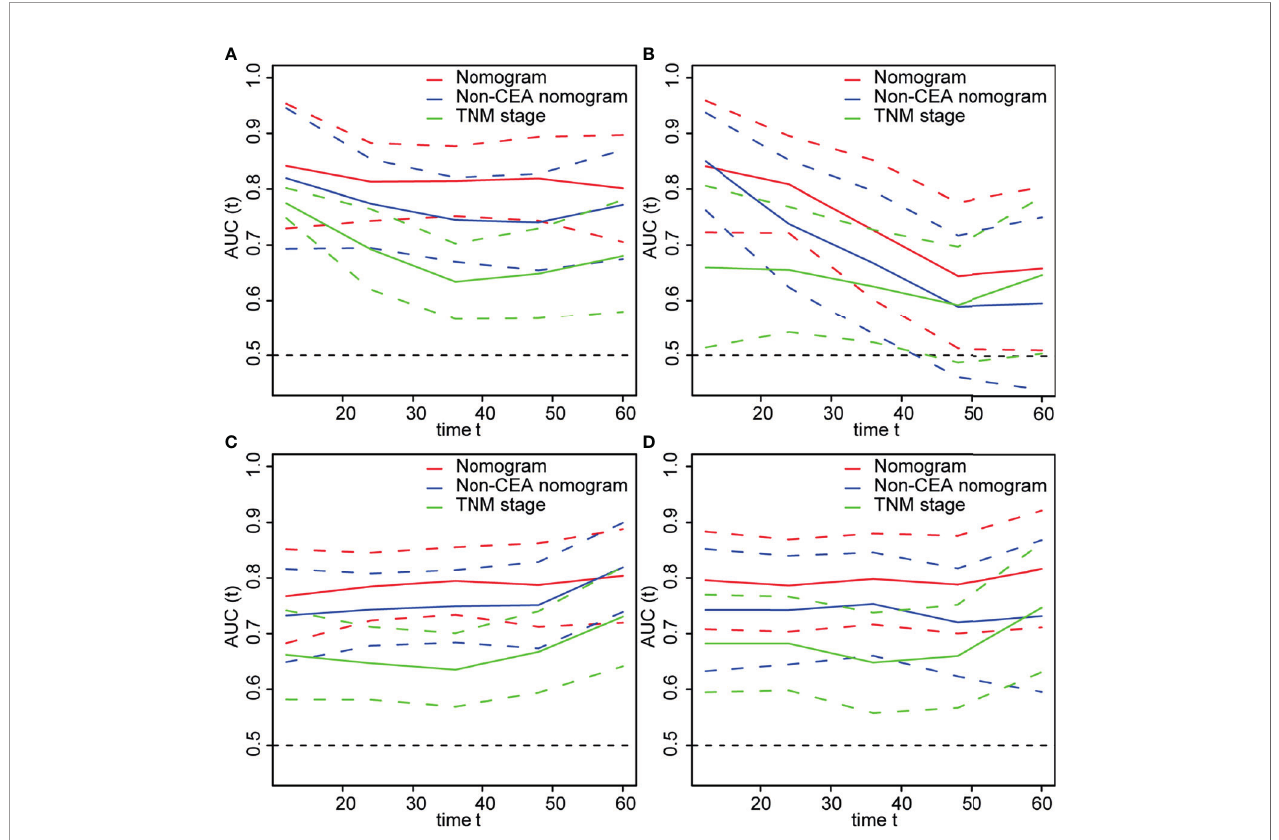
FIGURE 4 | The area under time-dependent receiver operator characteristic curve (ROC) of models for predicting survival in the (A) discovery and (B) testing cohorts and predicting recurrence in the (C) discovery and (D) testing cohorts. Nomogram: Body mass index (BMI) + differentiation + N stage + lymphocyte-to- monocyte ratio (LMR) + postoperative carcinoembryonic antigen (post-CEA). Non-CEA nomogram: BMI + differentiation + N stage +